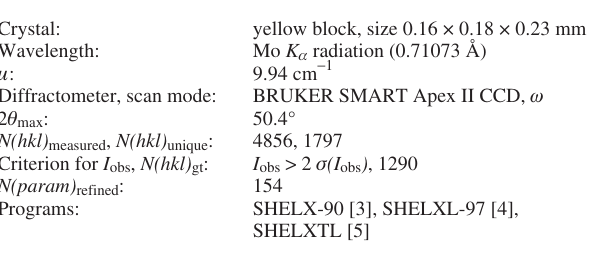
Table 1. Data collection and